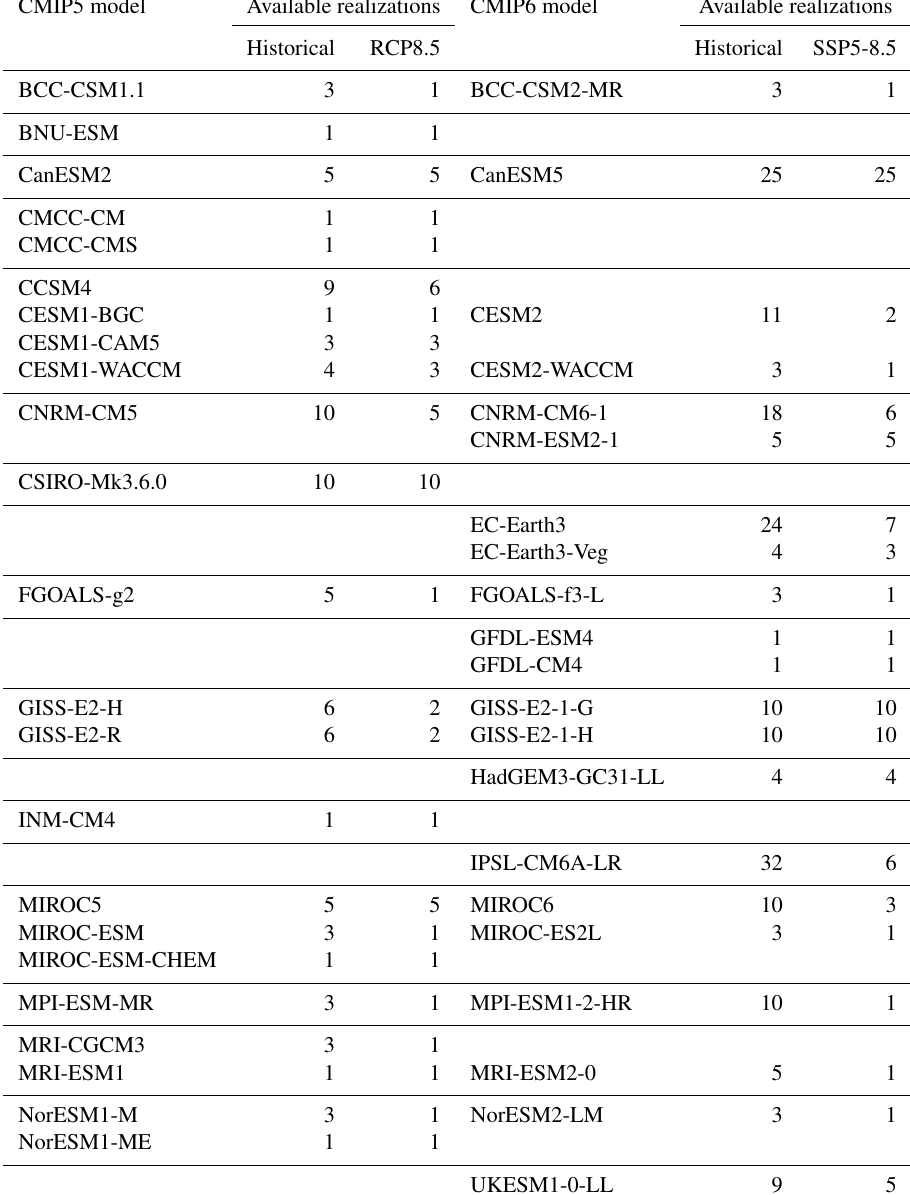
Table 2. Number of CMIP5 and CMIP6 model realizations with available snow cover fraction (“snc”), snow water equivalent (“snw”), and surface air temperature (“tas”) for both historical and RCP8.5 and SSP5–8.5